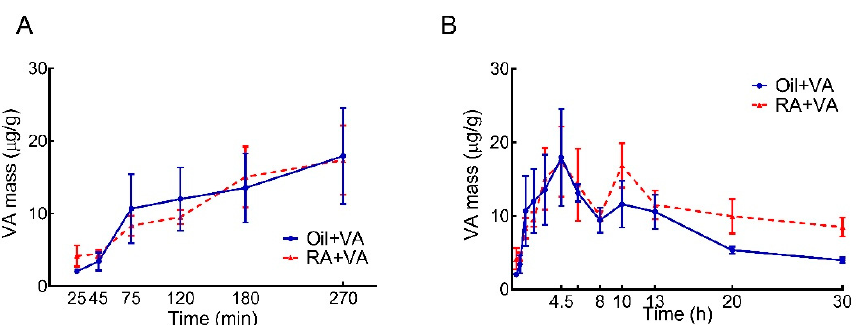
Figure 1. Intestinal VA concentration vs. time after oral administration of VA supplement in neona- tal rats: ( A ) During the first absorptive phase; ( B ) Over the entire study. Data are presented as means ± SEM, n = 4–6 pups/time/group.